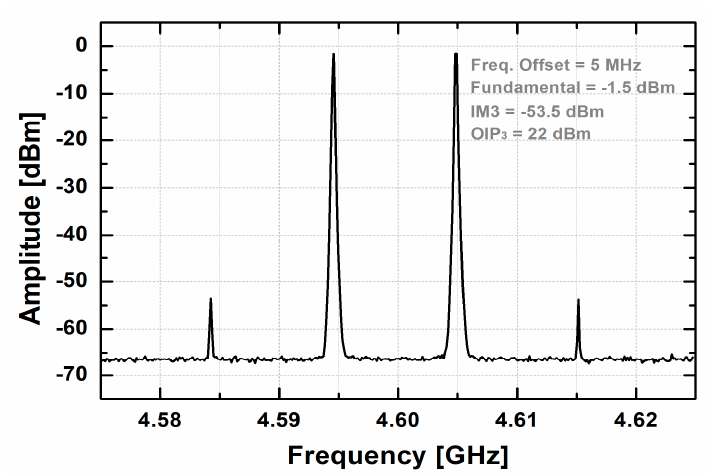
Figure 7. The simulated and measured gain, output power (P OUT ), and power-added efficiency (PAE) of the implemented PA.